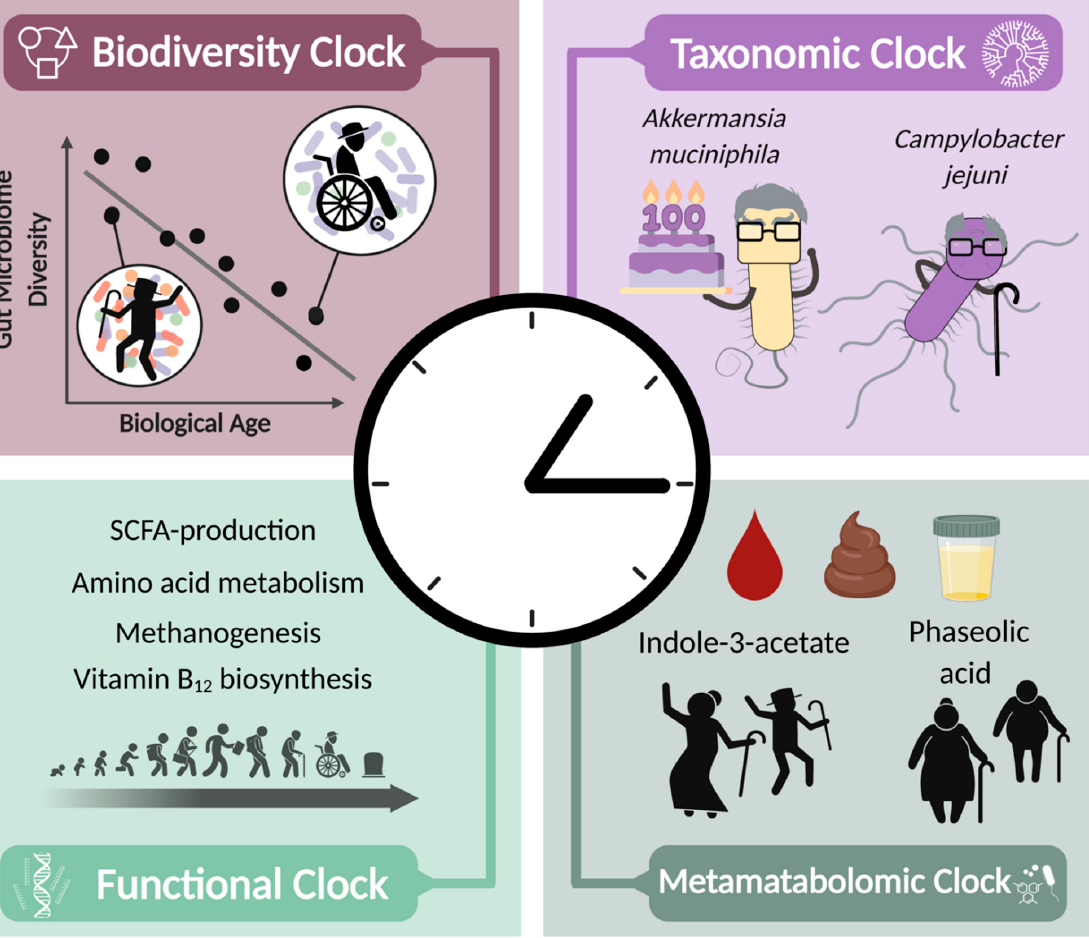
Figure 1. Four microbiome-based aging clocks. Age-related decline in gut microbiome biodiversity can be used to determine biological age. Certain species are enriched in different individuals and relate to the biological clock; for example, A. muciniphila is enriched in centenarians and is associated with longevity, while C. jejuni is enriched in individuals with higher biological age. Metagenomic and metatranscriptomic analysis gives insights into microbiome functions that affect host aging. Metametabolomics of blood, urine, or stool can identify microbiome-derived metabolites associated with biological age. SCFA: short-chain fatty acids. Figure created with BioRender (biorender.com). Sala et al. [80] proposed a diversity-based model for estimating healthy aging, the ‘Hybrid Niche Nature Model’, in which they incorporated Hubbell’s diversity index, a measure that focuses on species that are rare and most abundant, instead of traditional methods for richness and evenness (e.g., Shannon or Simpson indices). Analyzing 1649 stool samples from six 16S rRNA sequencing data sets, representing a wide range of dietary habits, health status, ages (0 to 109 years), and nationalities, showed an increase in microbial diversity in healthy aged individuals, while decreased microbial diversity was associated with unhealthy phenotypes at older ages. Based on data obtained from the ELDERMET study (the most comprehensive study of microbiome data from older people to date), the model was suggested to constitute a good predictor of the health status in aged individuals, even more so than the commonly used diversity quantification methods, such as Shannon, Simpson, Pielou, and Hill’s indices [80]. Although the gut microbiome α -diversity is significantly associated with health and age, centenarian microbiomes vary widely across data sets and geographical locations, limiting the ability